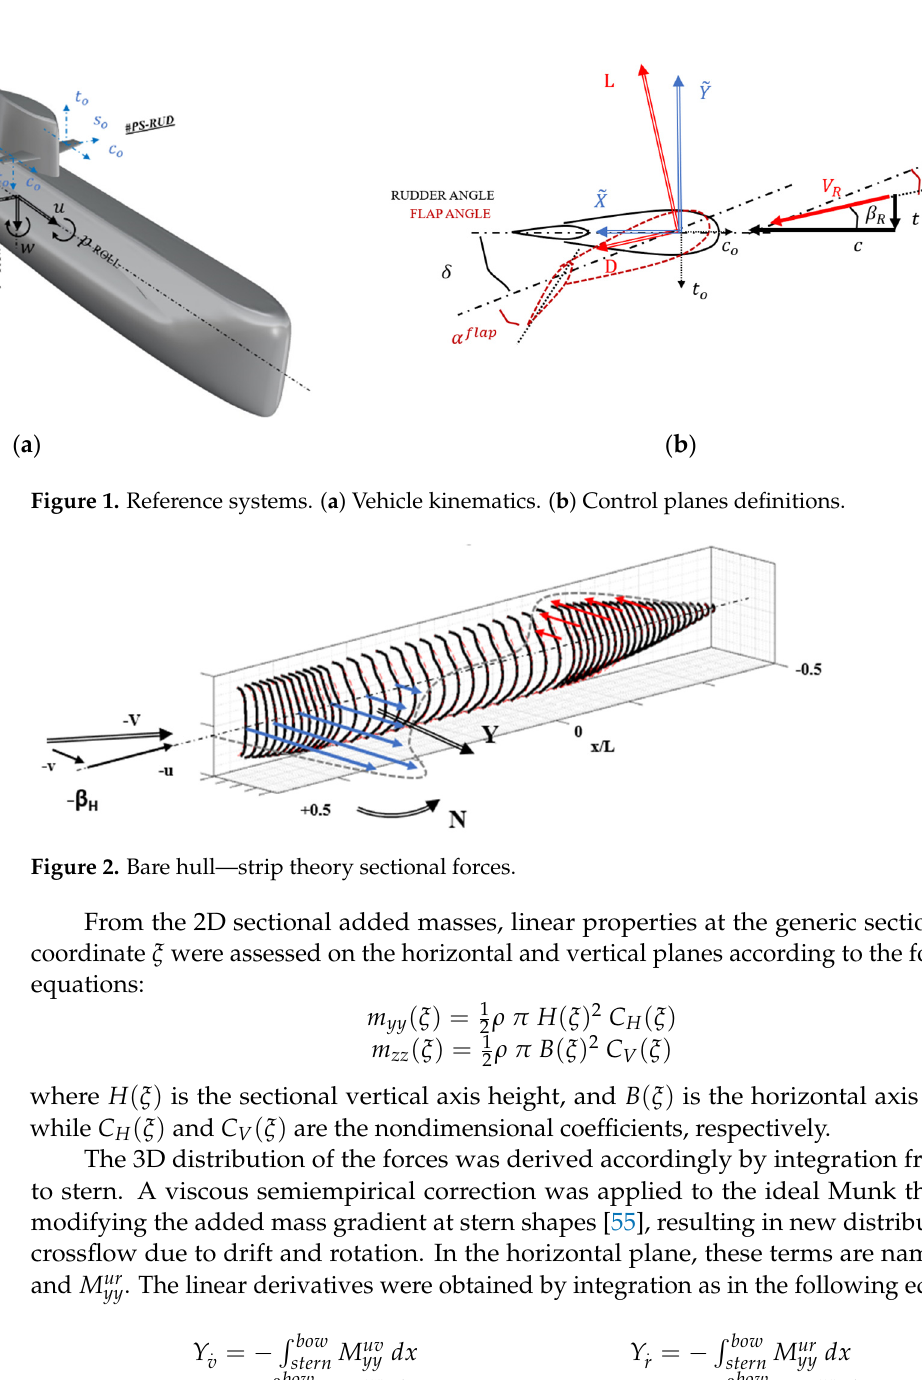
Figure 1. Reference systems. ( a ) Vehicle kinematics. ( b ) Control planes definitions.